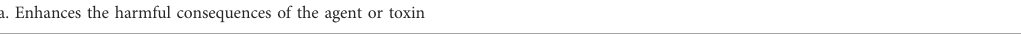
TABLE 2 Dual-use research of concern